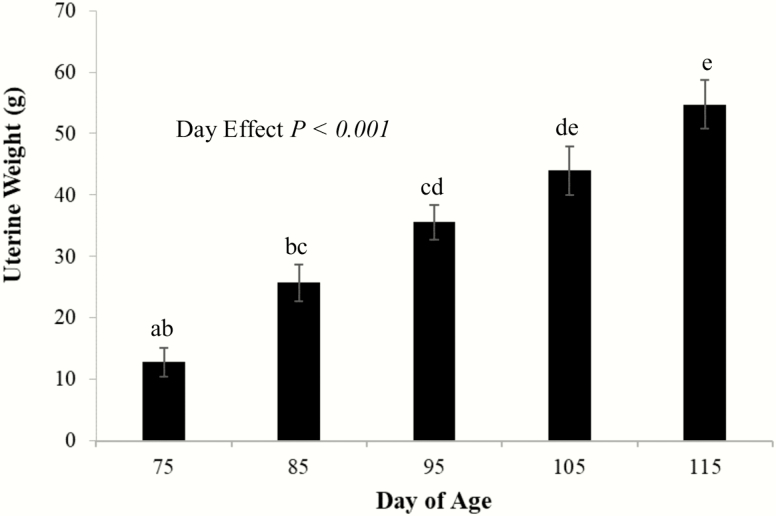
Average uterine weight of sacrificed gilts on postnatal days 75, 85, 95, 105, and 115. As gilts progressed in age, uterine weight increased across postnatal days 75 to 115. The increased weight of the reproductive tract is temporally associated with increased ovarian activity. Different superscripts represent statistical significance (P < 0.05).